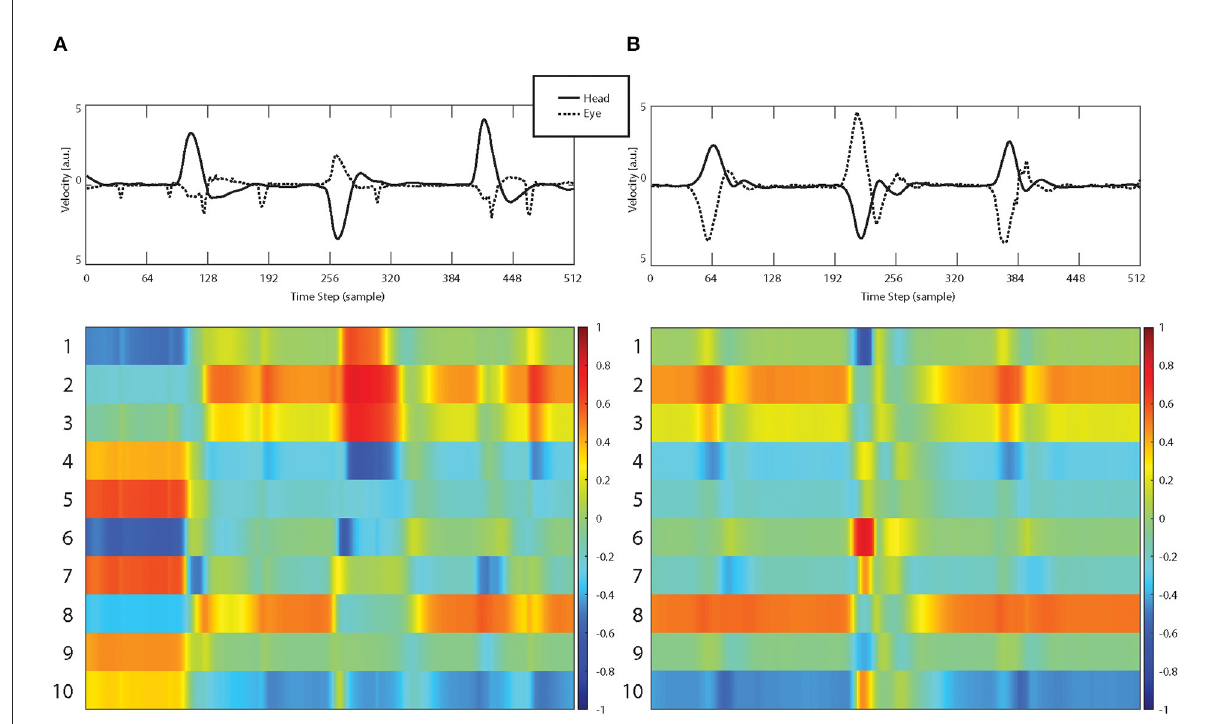
FIGURE2 Examples of vHIT input streams (top row, raw data including artifacts) consisting of eye velocity (dashed curve) and head velocity (continuous curve) time series and corresponding activation patterns of the first 10 hidden LSTM layers for a patient with AUVP (A) and a stroke patient (B) .